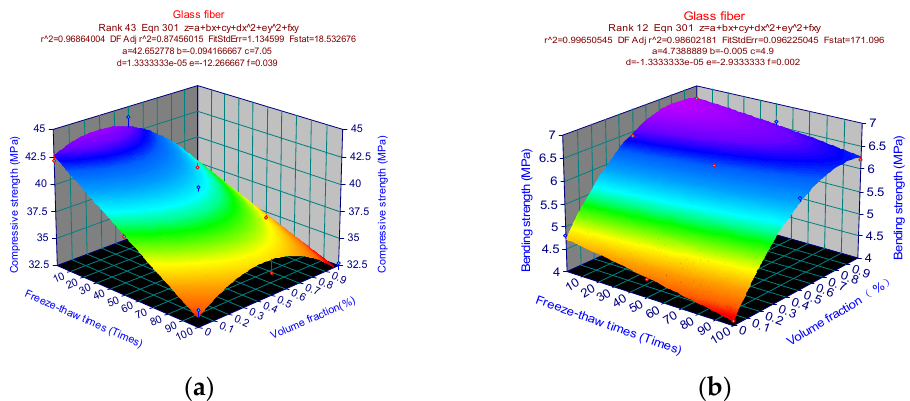
Figure 17. Glass fiber strength prediction mode: ( a ) Compressive strength prediction model; ( b ) Bending strength prediction model.